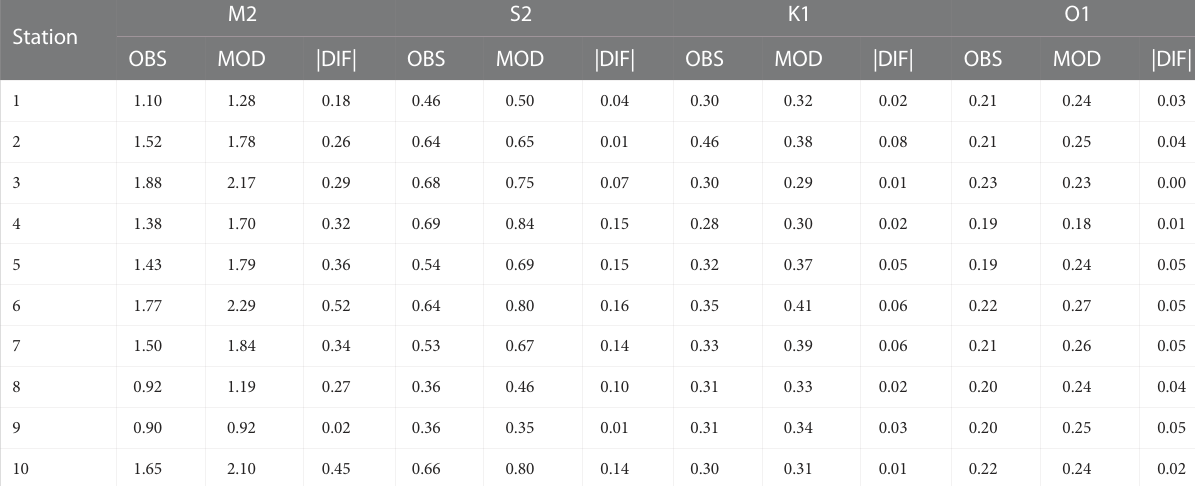
TABLE 1 The comparison of amplitudes (m) between the observation and simulation of the major four tidal components.